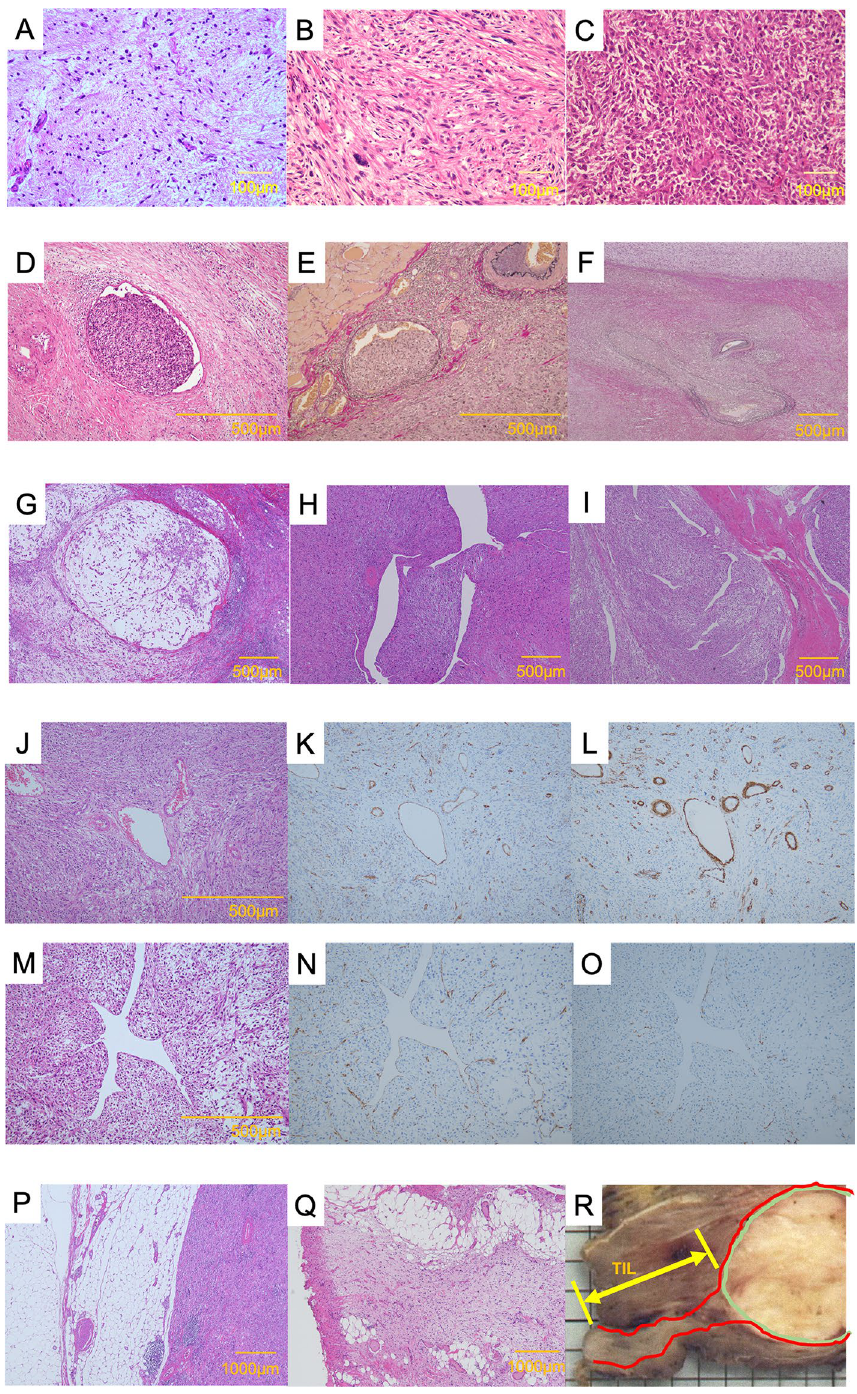
Figure 1. Cellularity classification. Hematoxylin and eosin (H&E) staining results showing ( A ) low (< 20%), ( B ) medium (20–50%), and ( C ) high (> 50%) cell contents. ( D ) Vascular invasion. ( E ) Elastica van Gieson (EVG) staining showing a small vascular invasion. Clefts are formed, and red blood cells are visible in the clefts. ( F ) Slightly larger vascular invasion with EVG staining, showing almost no cleft space. ( G ) Myxoid area in an undifferentiated sarcoma observed via H&E staining. ( H ) Sickle-shaped blood vessels observed via H&E staining. ( I ) Cluster of small sickle-shaped blood vessels observed via H&E staining. ( J ) Round-shaped blood vessels observed via H&E staining. ( K ) Anti-CD31 staining of the round-shaped blood vessel in panel j; the lumen is covered. ( L ) Anti-αSMA staining of the round-shaped blood vessel in panel j; positive cells are uninterrupted around the vessel. ( M ) Sickle-shaped blood vessels observed via H&E staining. ( N ) Anti-CD31 staining of vessels in panel m; the clefts are covered by the vascular endothelium, indicating a vascular lumen rather than an artifact. ( O ) Anti-αSMA staining of the sickle-shaped blood vessels in panel m, showing intermittent coverage by positive cells, mainly in the vascular branches. ( P ) INFa infiltration pattern with a clear border between the tumor and surrounding connective tissue observed via H&E staining. ( Q ) INFc infiltration pattern with tumor cells infiltrating into the surrounding connective tissue observed via H&E. ( R ) Differences in tail-like infiltration length (TIL) measurements between the macroscopic and microscopic tumor areas, showing gross (green line) and microscopic (red line) coverage